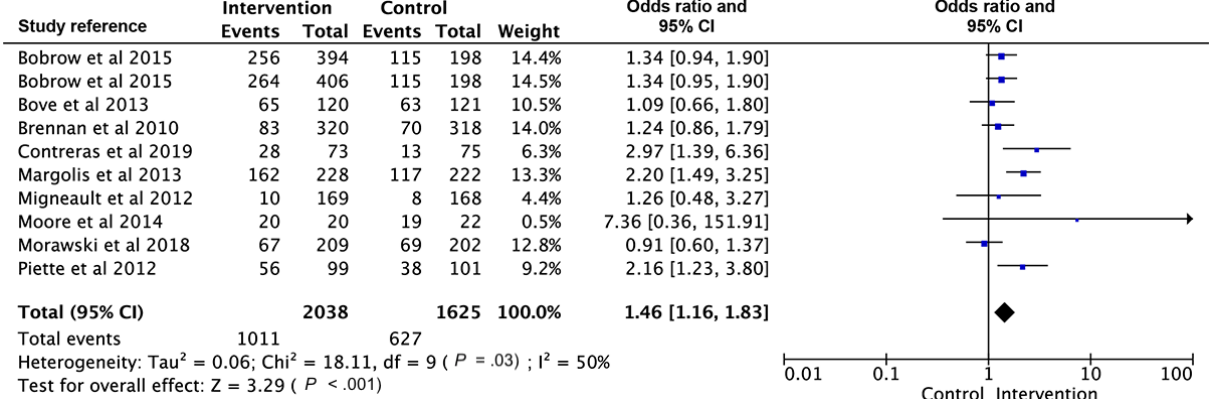
Figure 4. Forest plot of the difference of blood pressure control between intervention and control